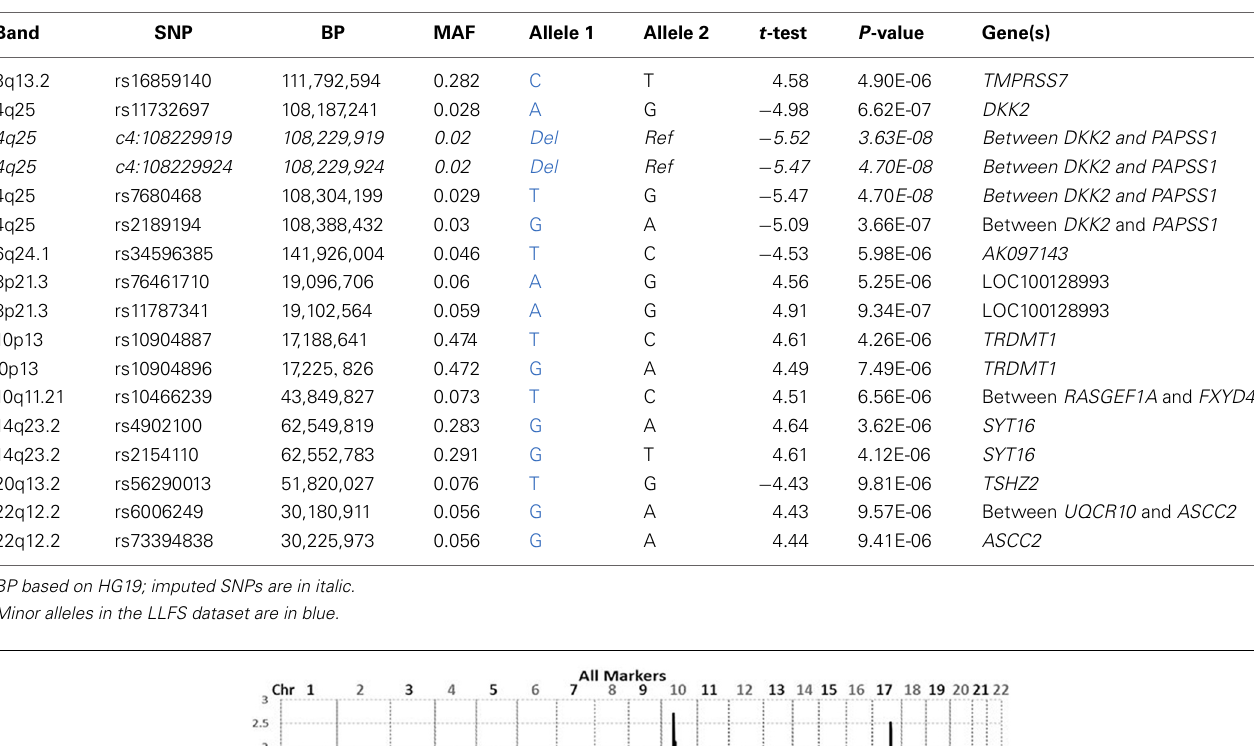
Table 3 | Candidate SNPs from the genome wide association analysis. Band SNP BP MAF Allele 1 Allele 2